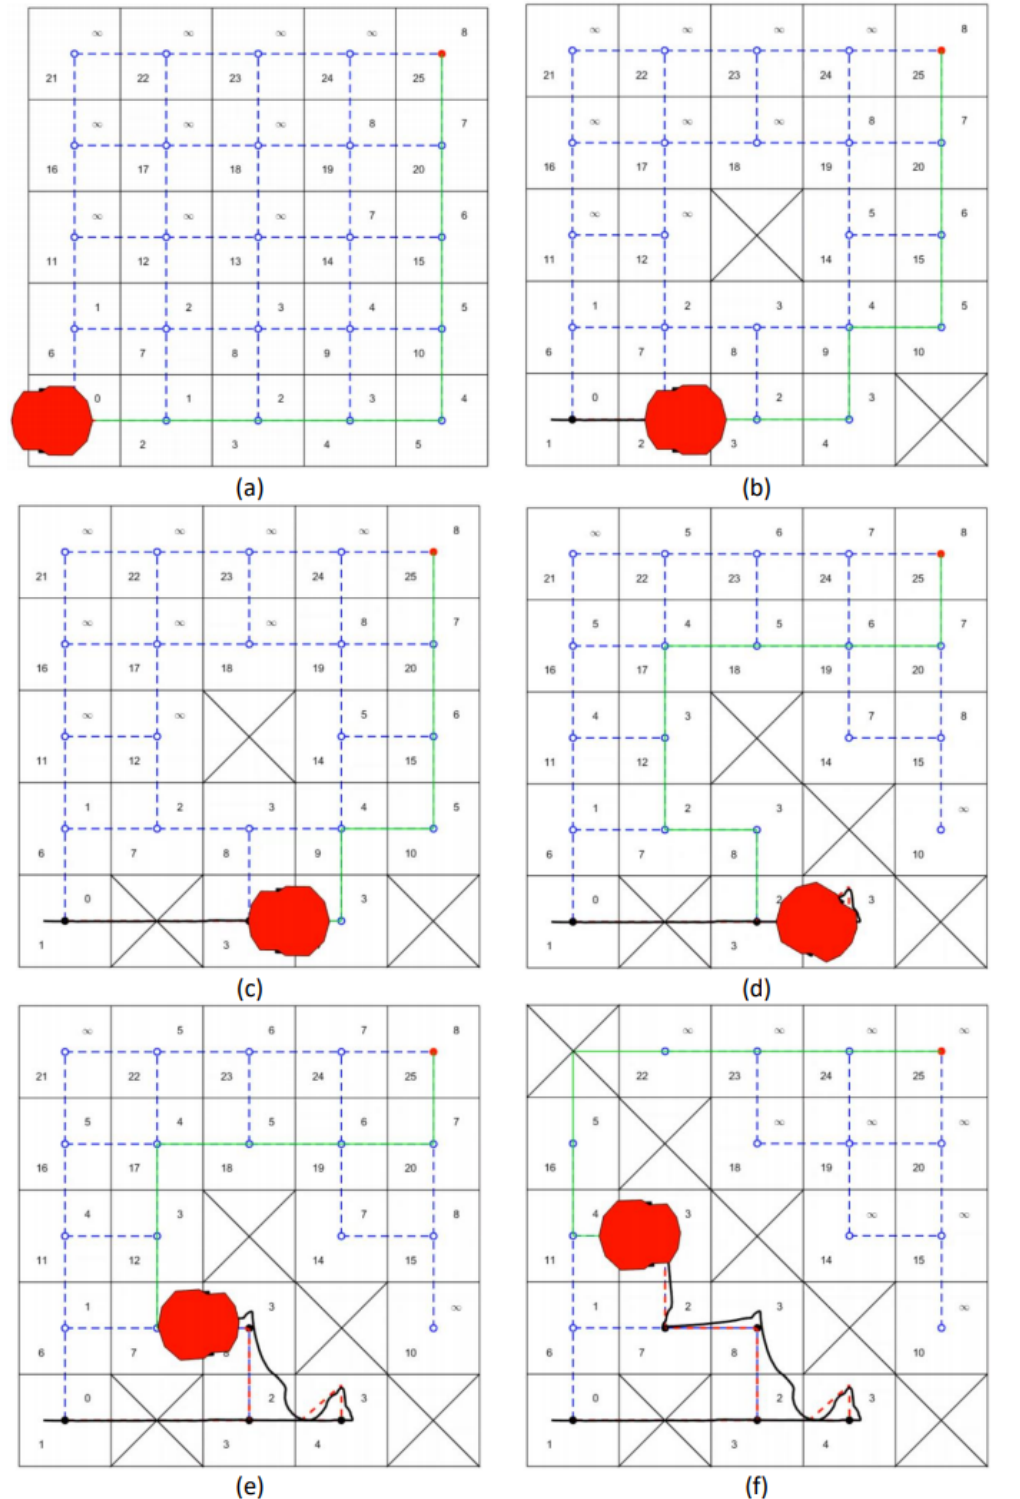
Figure 9. Experiment 2: The impossible route. Snapshots of the path traveled, from the initial state ( a ) to the final one ( f ), passing by some intermediate stages ( b – e